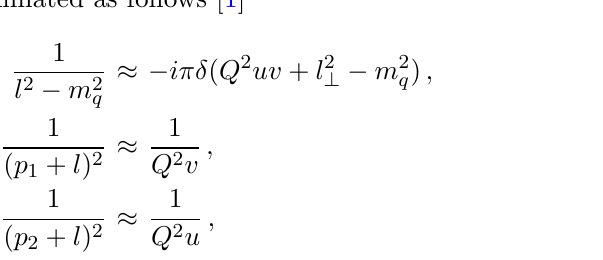
Figure 1 . The leading-order one-loop Feynman diagrams for (a) quark scattering by the ( G a vertex (black circle) and (c) the Higgs boson production in gluon fusion. The diagrams (b) and (d) with the e(cid:11)ective vertices (gray circles) de(cid:12)ned in the text represent the non-Sudakov double- logarithmic corrections to the process (a) and (c),